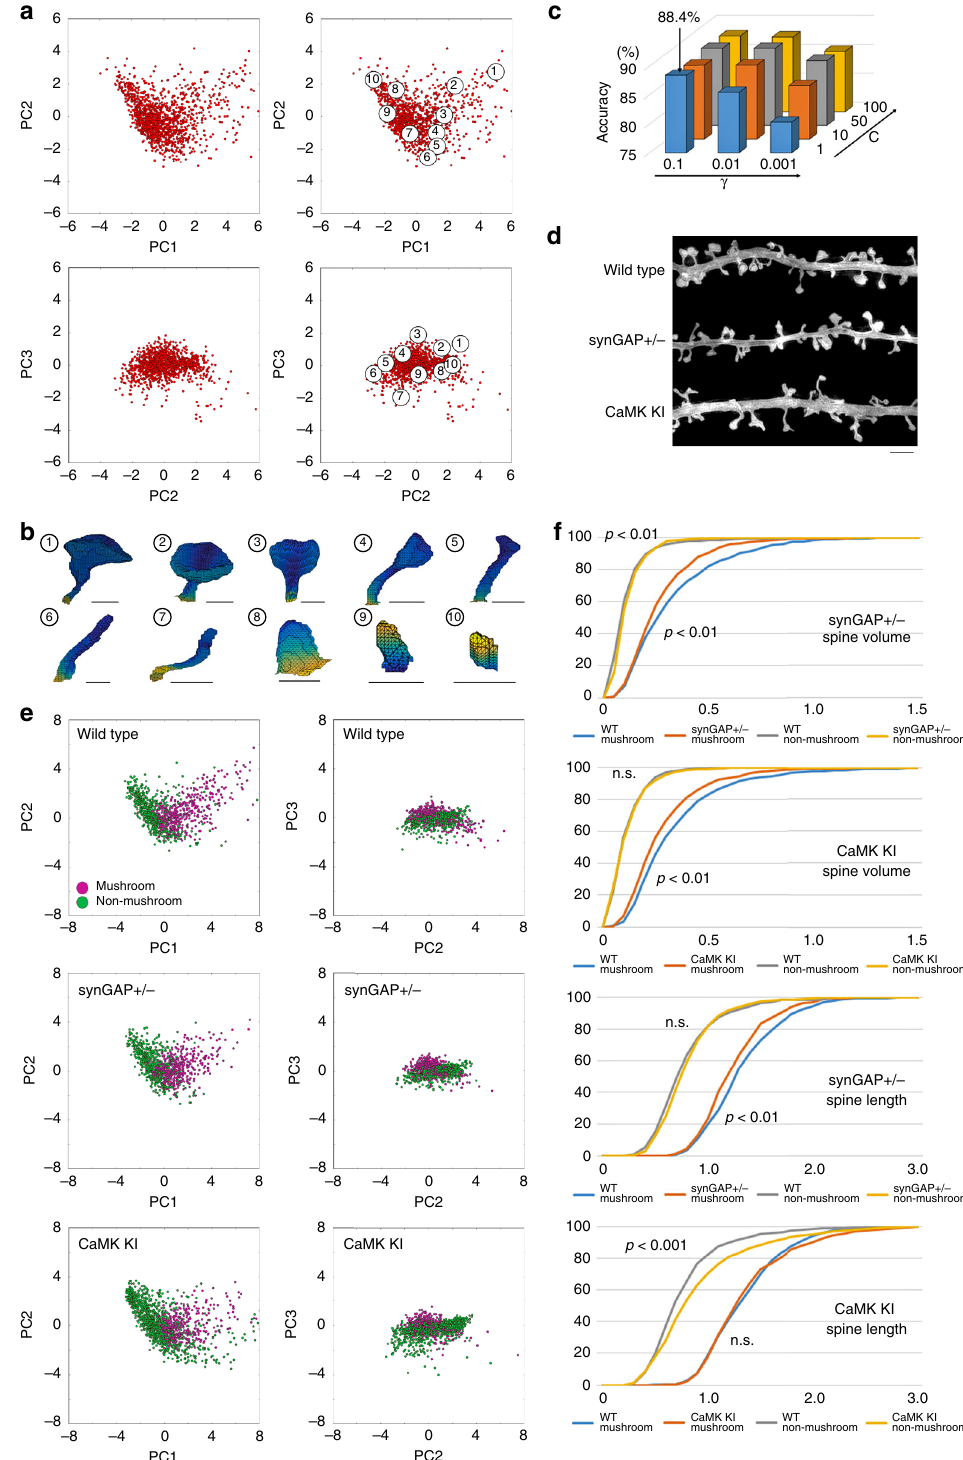
detected by high-resolution confocal microscopy applied to intact brain tissue. We applied confocal microscopy with confocal aperture of 0.5 AU to CA1 pyramidal neurons expressing YFP in fi xed brain sections (Supplementary Fig. 11d, f). Horizontally and vertically protruding spines could be detected and converted to the